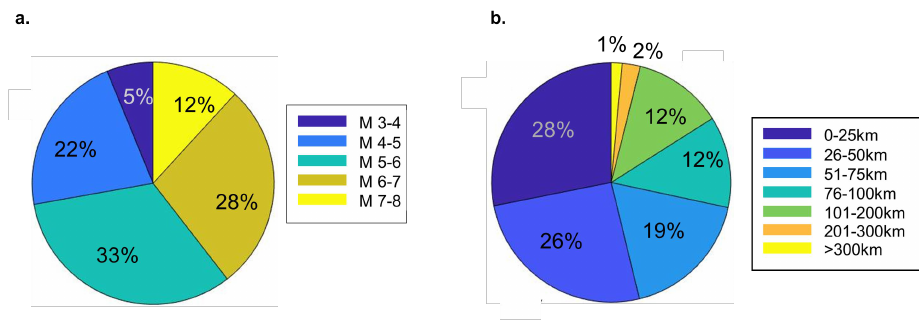
Figure 2. ( a ) Magnitude and ( b ) distance of Set-1 (ground motions from PEER NGA-West2).